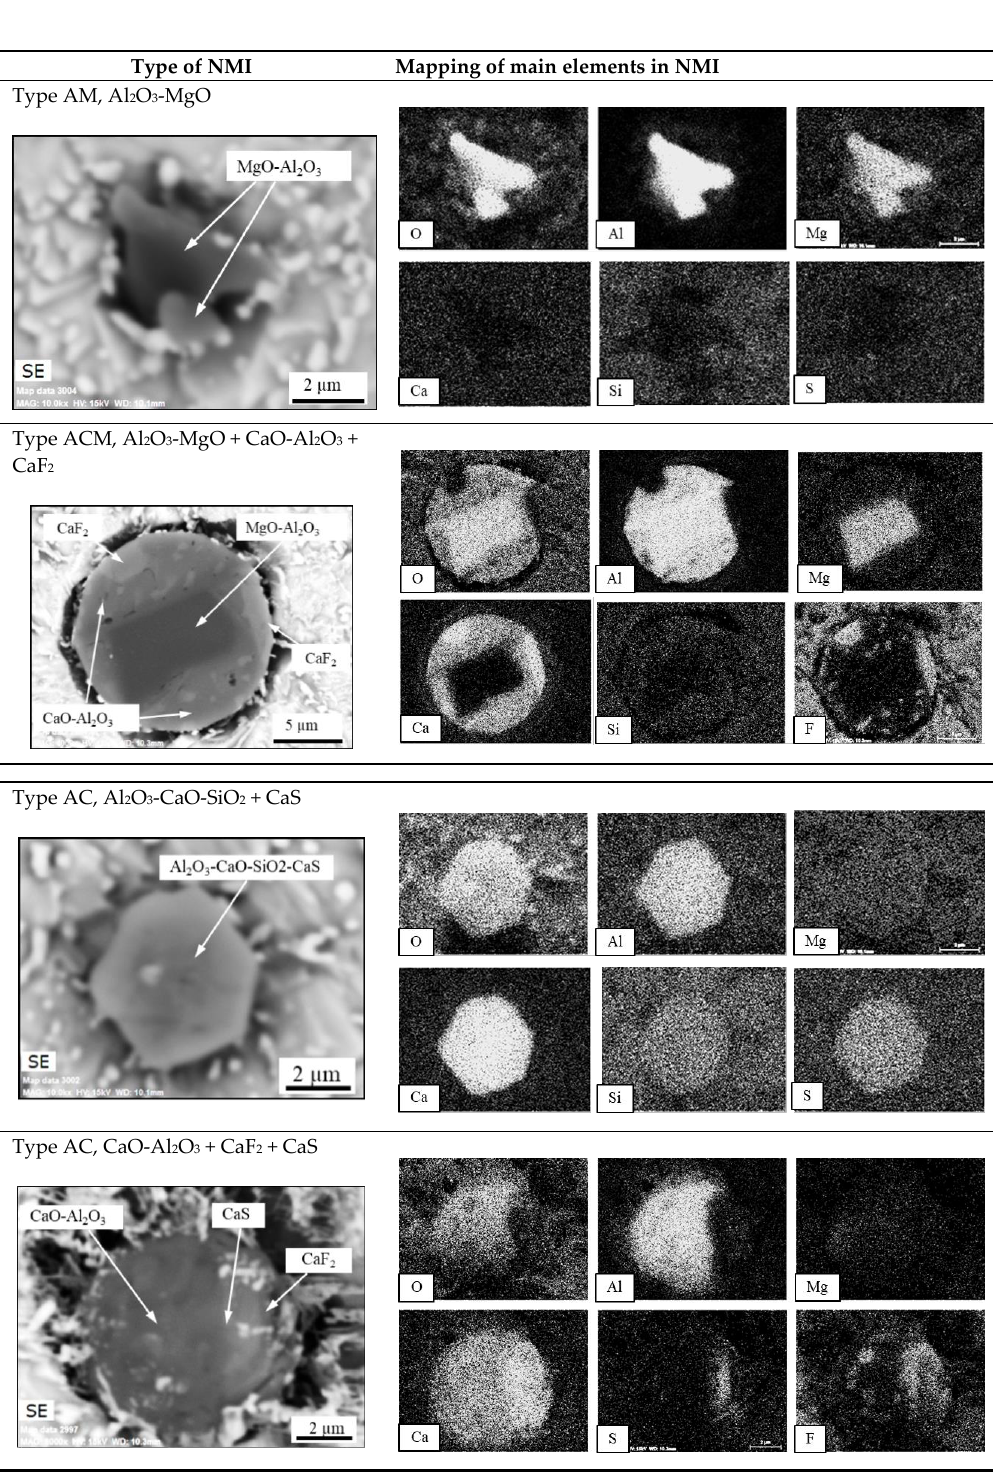
Figure 6. Typical oxide inclusions in different samples observed by three-dimensional (3-D) investigations on surfaces of steel samples after electrolytic extraction; ( a ) Type A: Al 2 O 3 ; ( b ) Type AM: Al 2 O 3 -MgO; ( c ) Type ACM: Al 2 O 3 -MgO + CaO-Al 2 O 3 + CaF 2 ; ( d ) Type AC: CaO-Al 2 O 3 + (CaF 2 + CaS).